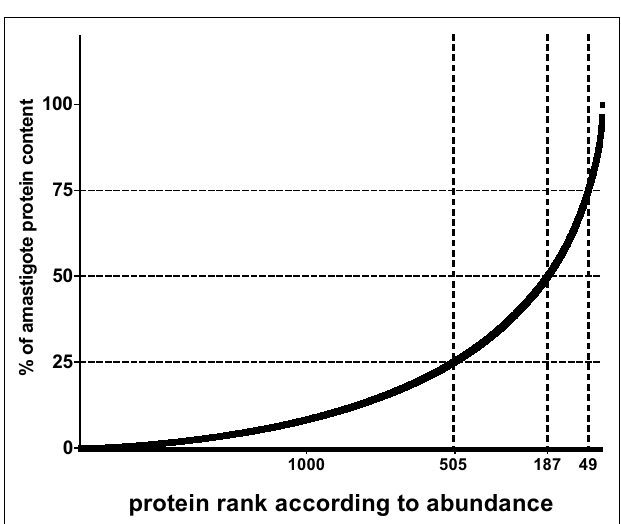
FIGURE 1 | Relative contribution of individual proteins to total protein content of Leishmania amastigotes . For illustration, the contribution of each of 1764 proteins detected by shot gun proteomics in L. mexicana amastigotes (66) is expressed as percent to total protein mass and values plotted in ordered fashion for each protein. Numbers on X -axes show the rank of the n th protein at the thresholds of 75, 50, and 25% of total mass.